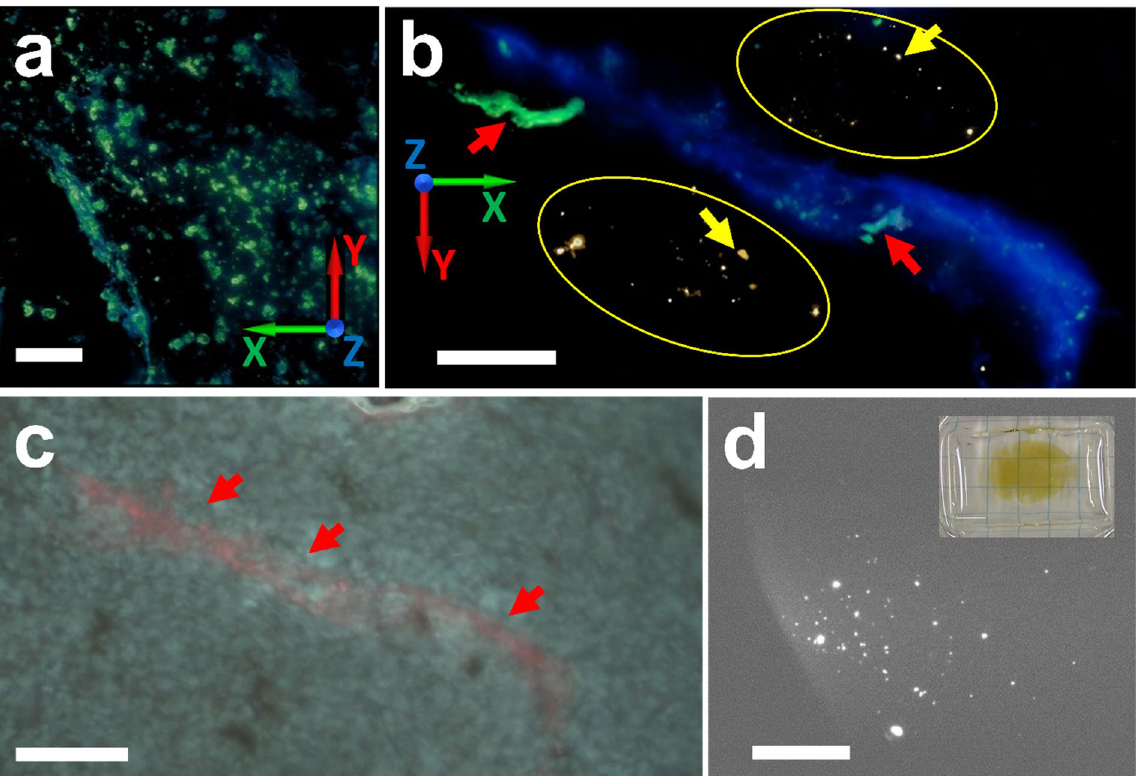
Figure 5. (a , b ) MAXWELL images of mouse brain perfused with SciNPs (NaGdF 4 :Eu) to delineate the microvessels induced by tumor angiogenesis. SciNPs found outside the blood vessels, such as those marked by yellow arrows and circles, are attributed to the leakage through the fenestrations on the angiogenic microvessel walls. Red arrows mark microvessels with diameter ≤ 10 µm. ( c ) A micrograph obtained with UV illumination shows the red light emission of SciNPs aggregated in the microvessels. ( d ) Low-magnification MAXWELL images showing the aggregation of SciNPs in a region of a mouse brain. Inset: the entire brain imaged after tissue clearing. Scale bars: ( a ) 10 µm; ( b,c ) 50 µm; ( d ) 1 mm; inset: 5 Before perfusion with SciNPs, the mouse was sacrificed by an overdose of Zoletil 50 (Virbac Laboratories, Carros, France, 1 mg/20 g bodyweight) administered by intraperitoneal injection. A catheter (PE-08, BB31695, ID 0.2 mm, OD 0.36 mm, Scientific Commodities, Inc.) was inserted into the right common carotid artery of the mouse and vessel is fixed with silk sutures. The tubing was secured with two knots around the CCA and then perfused with 2 ml heparinized (500 U/mL) NaGdF 4 :Eu SciNPs (10 mg/mL in 5% glucose buffer). The brain tis- sue specimens were immersed in 4% paraformaldehyde for 24 h. After fixation, the tissues were washed by PBS three times and sliced to 100 μm thickness by a vibratome (VT1200s, Leica Biosystems, Buffalo Grove, IL, USA). The slices were embedded in EverBrite™ Hardset Mounting Medium with DAPI (Biotium, Fremont, CA, USA).